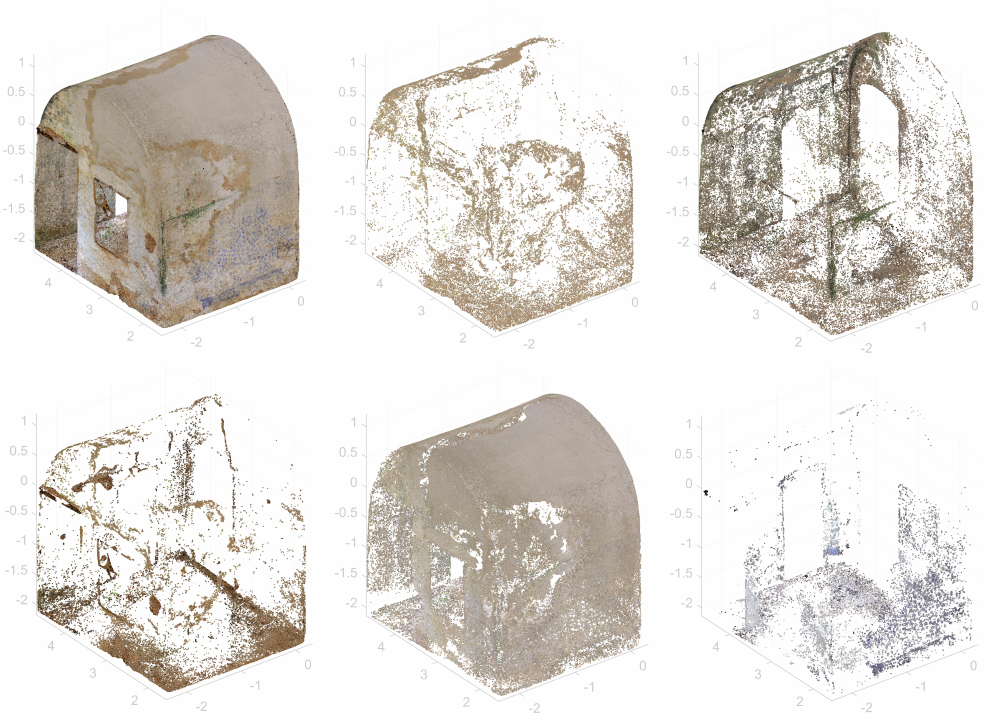
Figure 5 Hierarchical segmentation in HSV (Case 2): a) original point cloud; b) cluster 1: moist area (10%); c) cluster 2: biological colonization/patina (18%); d) cluster 3: spots/deposit (10%); e) cluster 4: unaltered surface (57%); f) cluster 5: staining (6%)